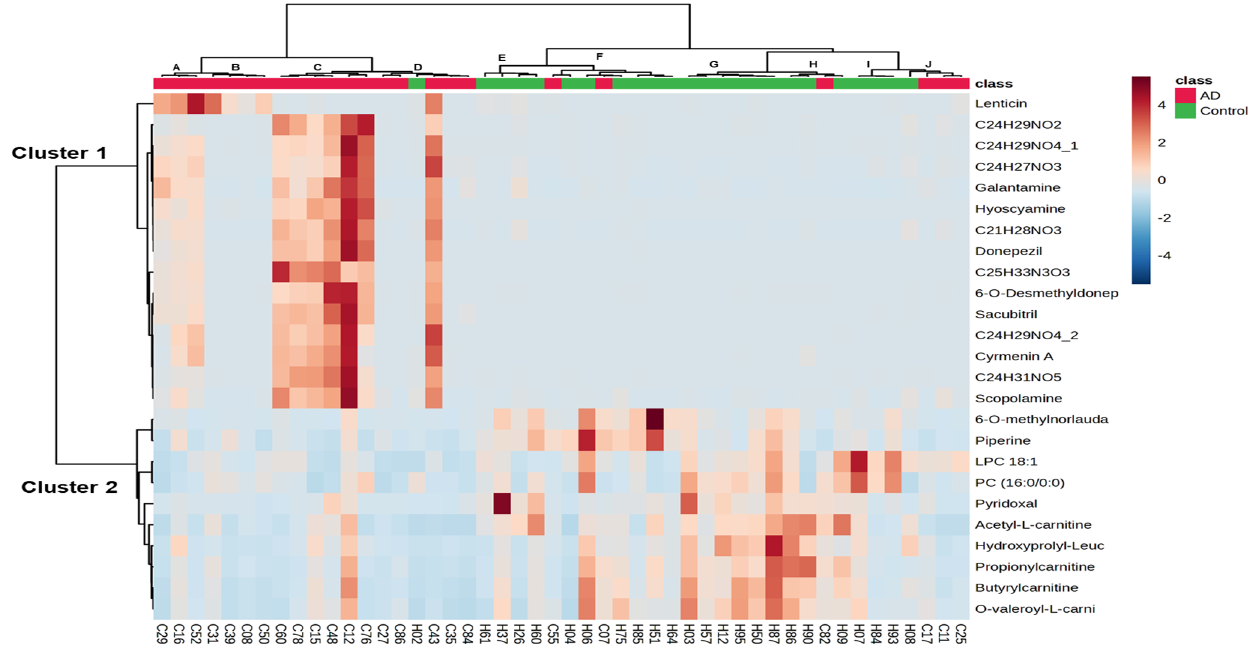
Figure 3. Two-way hierarchical clustering analysis (HCA) of 25 annotated metabolites in 48 hair samples. The rows represent 25 discriminatory metabolites whose p values are lower than 0.01 between patients with AD and controls, and the columns represent 48 hair samples. The z-score value of each feature among 48 hair samples is plotted in a red–blue color scale. The red color indicates that the abundances of the feature are higher than its average abundance among 48 samples, and bright blue indicates its abundances are approximately equal to its average abundance among 48 samples. Conversely, blue indicates its abundances are lower than its average abundance among 48 samples. The 48 hair samples could be grouped into 10 clusters (Clusters A~J) with similar peak feature profiles, and 25 annotated metabolites could be primarily grouped into 2 clusters (Clusters 1 and 2).